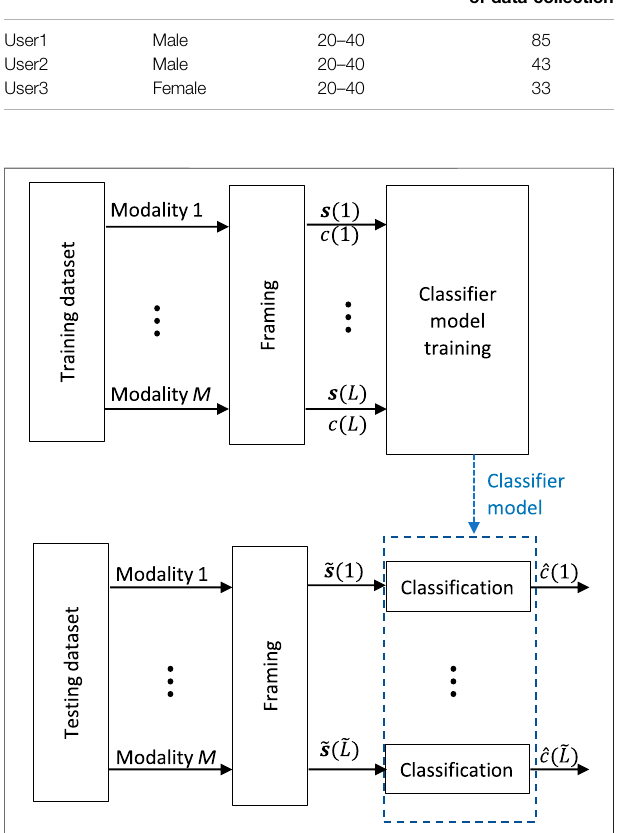
FIGURE 3 | Generic formulation of the transportation mode recognition problem: a recognition pipeline is developed and optimized on a training set, and thenevaluatedonadistinct testing set.Theselectionofsensormodalities and the partitioning of the data in the training and testing sets were provided by the challenge